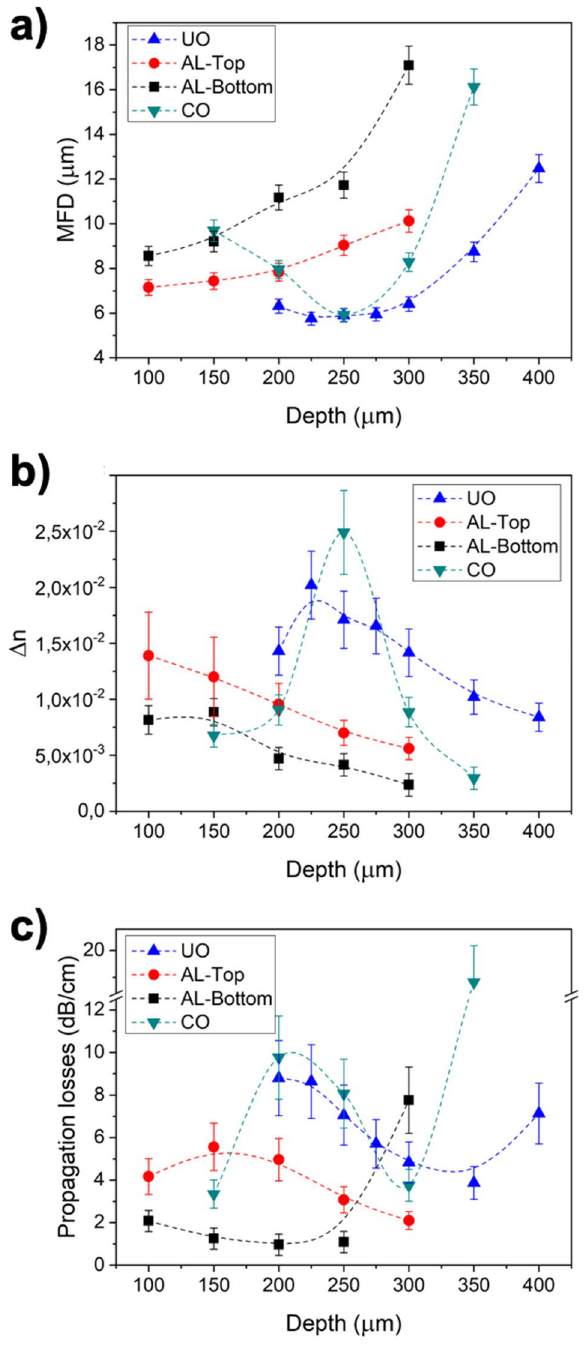
Figure 3. ( a ) Mode field diameter, ( b ) step refractive index and ( c ) propagation losses as a function of depth at 1640 nm for waveguides written with UO, AL and CO